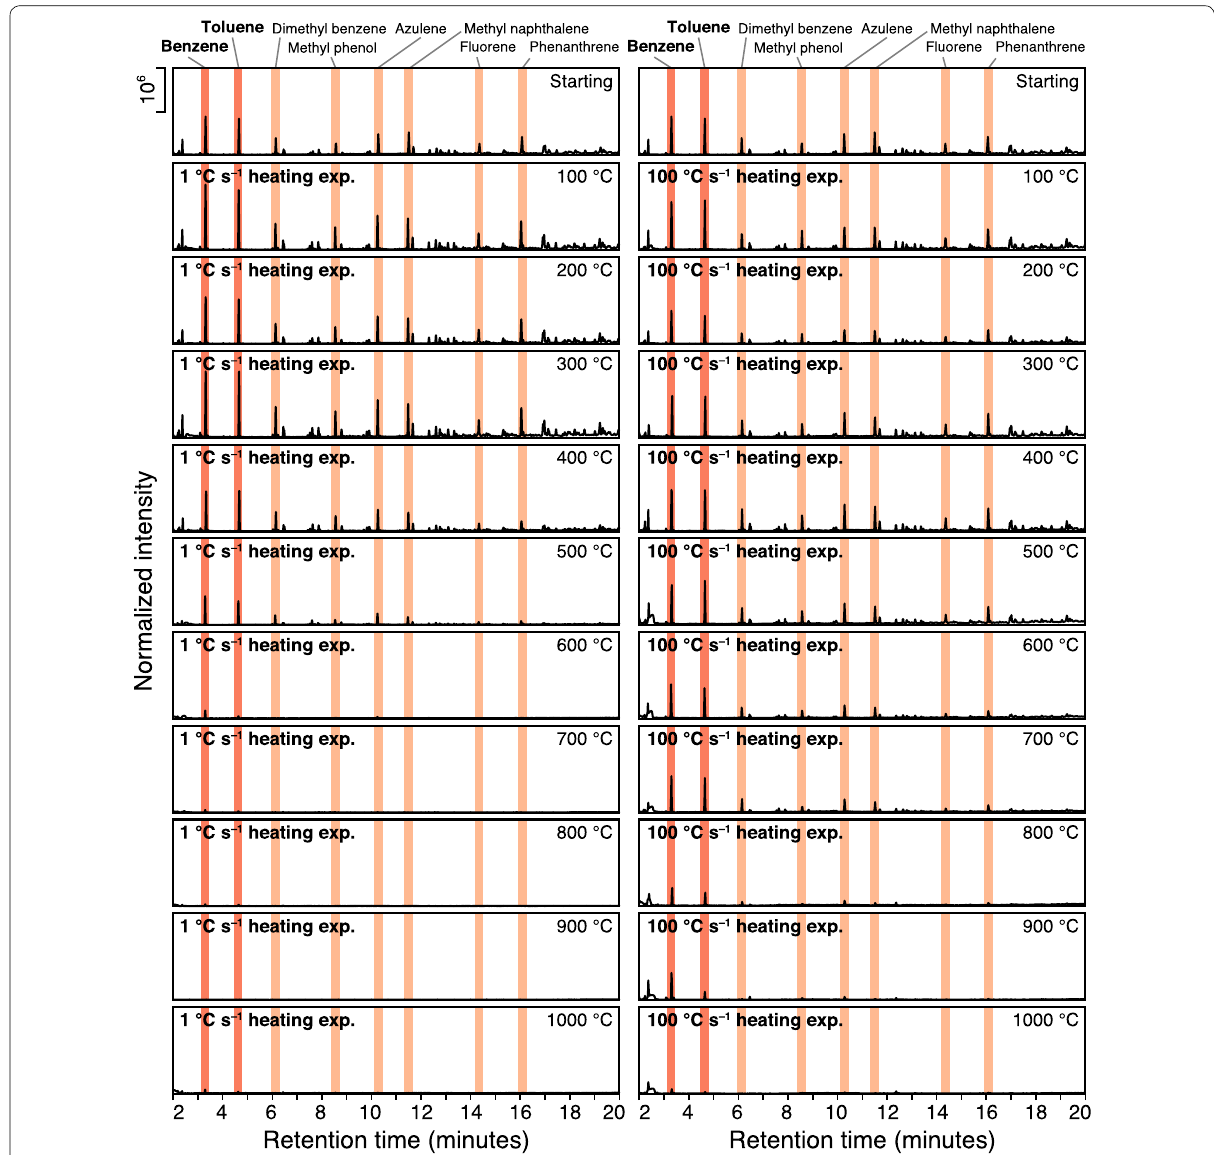
Fig. 5 Gas chromatographs of the analyzed CM. The two chromatographs at the top of each column show the composition of gas released from the starting CM. The lower 20 chromatographs show the compositions of gas released from the products heated at 1 °C s − 1 (left column) and 100 °C s − 1 (right column). exp .